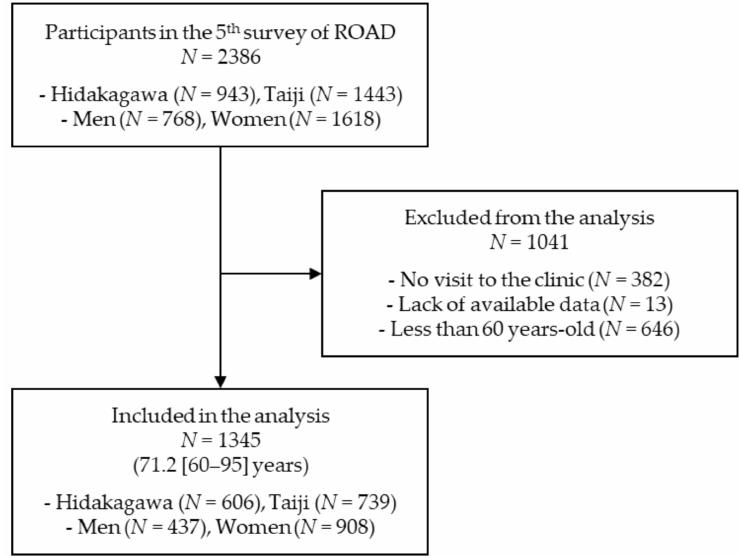
Figure 1. Flow chart of the recruitment of participants in this